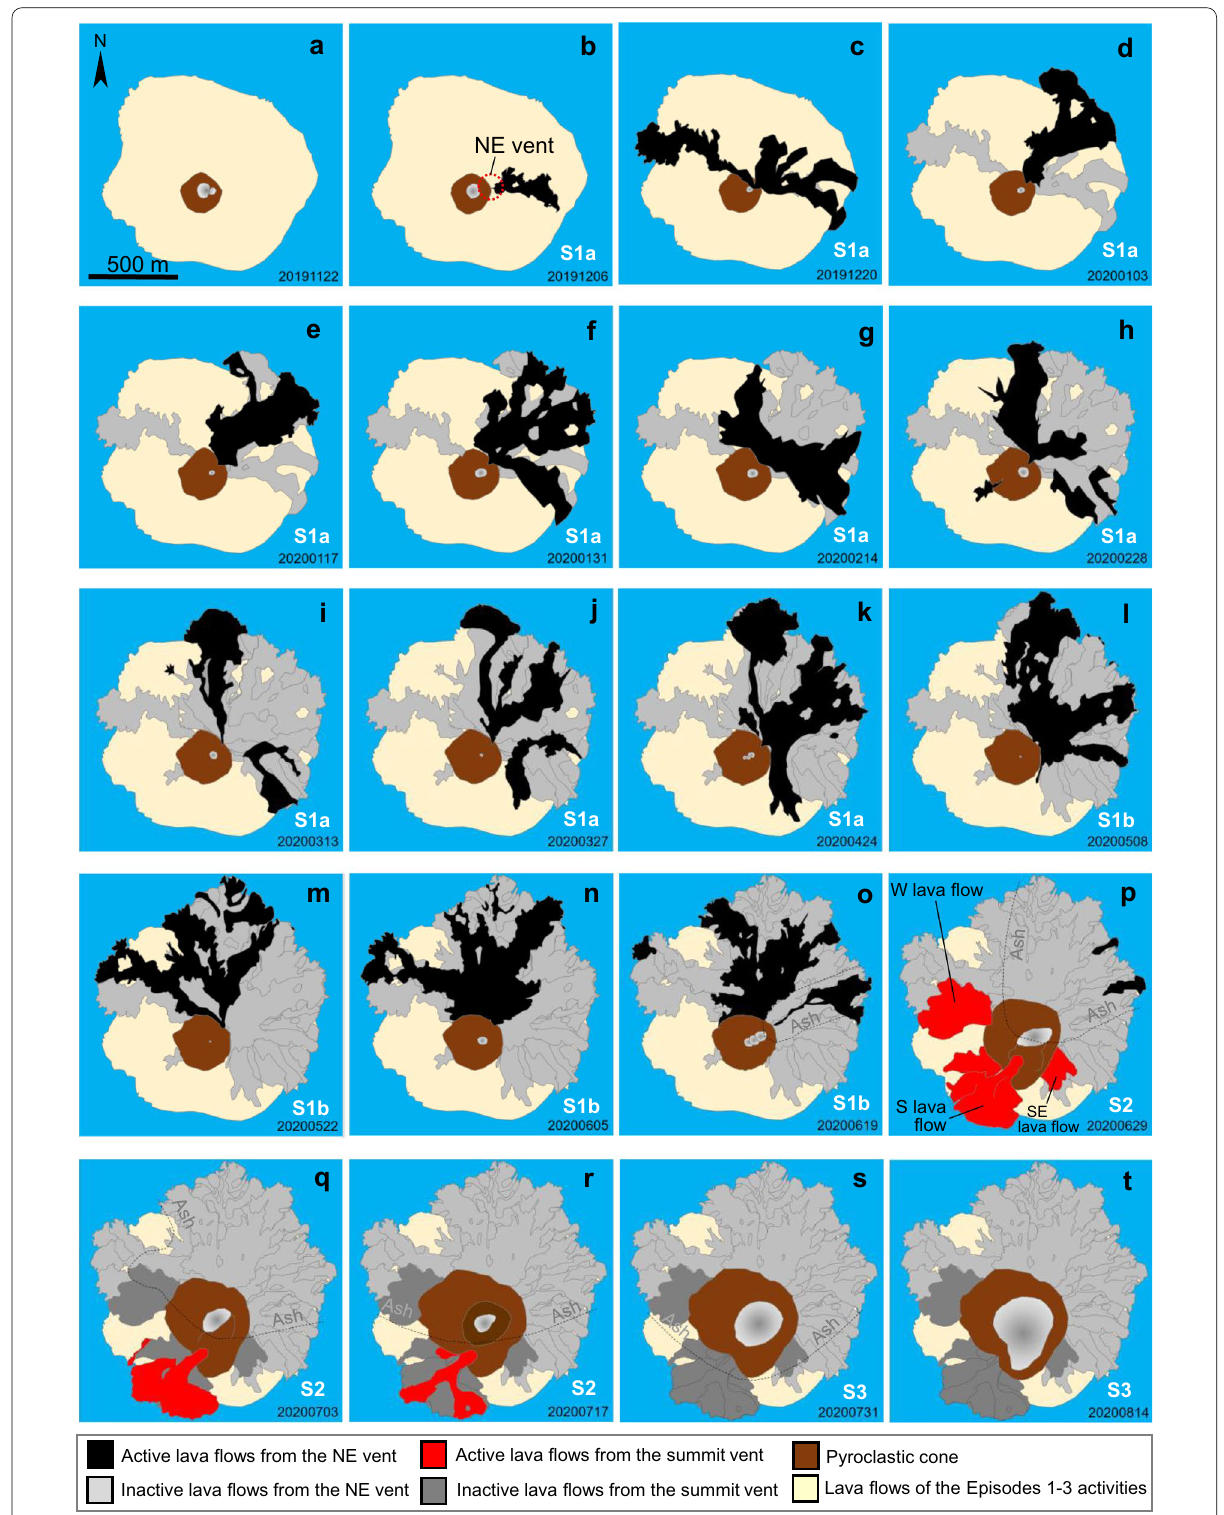
Fig. 4 a–t Eruption sequence of the Episode 4 activity based on a geological interpretation of the ALOS-2 images. S1a: Stage 1a; S1b: Stage 1b; S2: Stage 2; and S3: Stage